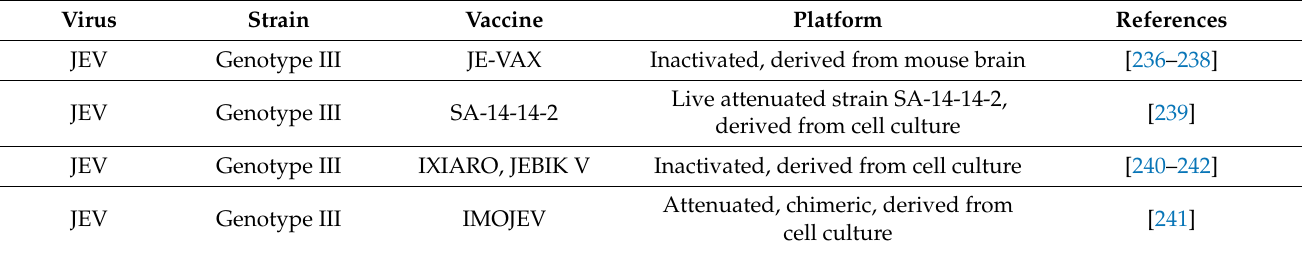
Table 4. Vaccines for JE serocomplex viruses that are licensed for use in